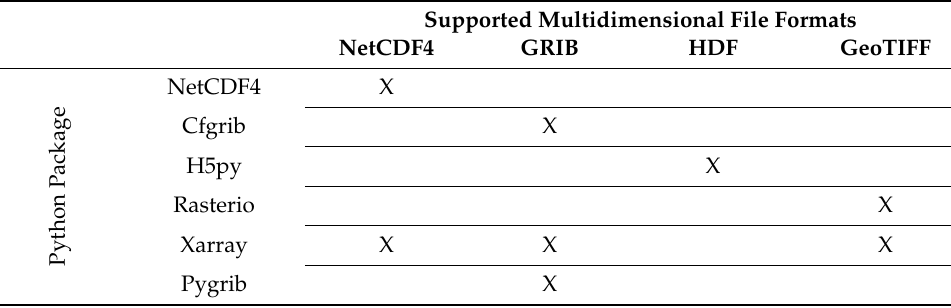
Table 2. Python Packages vs Supported File